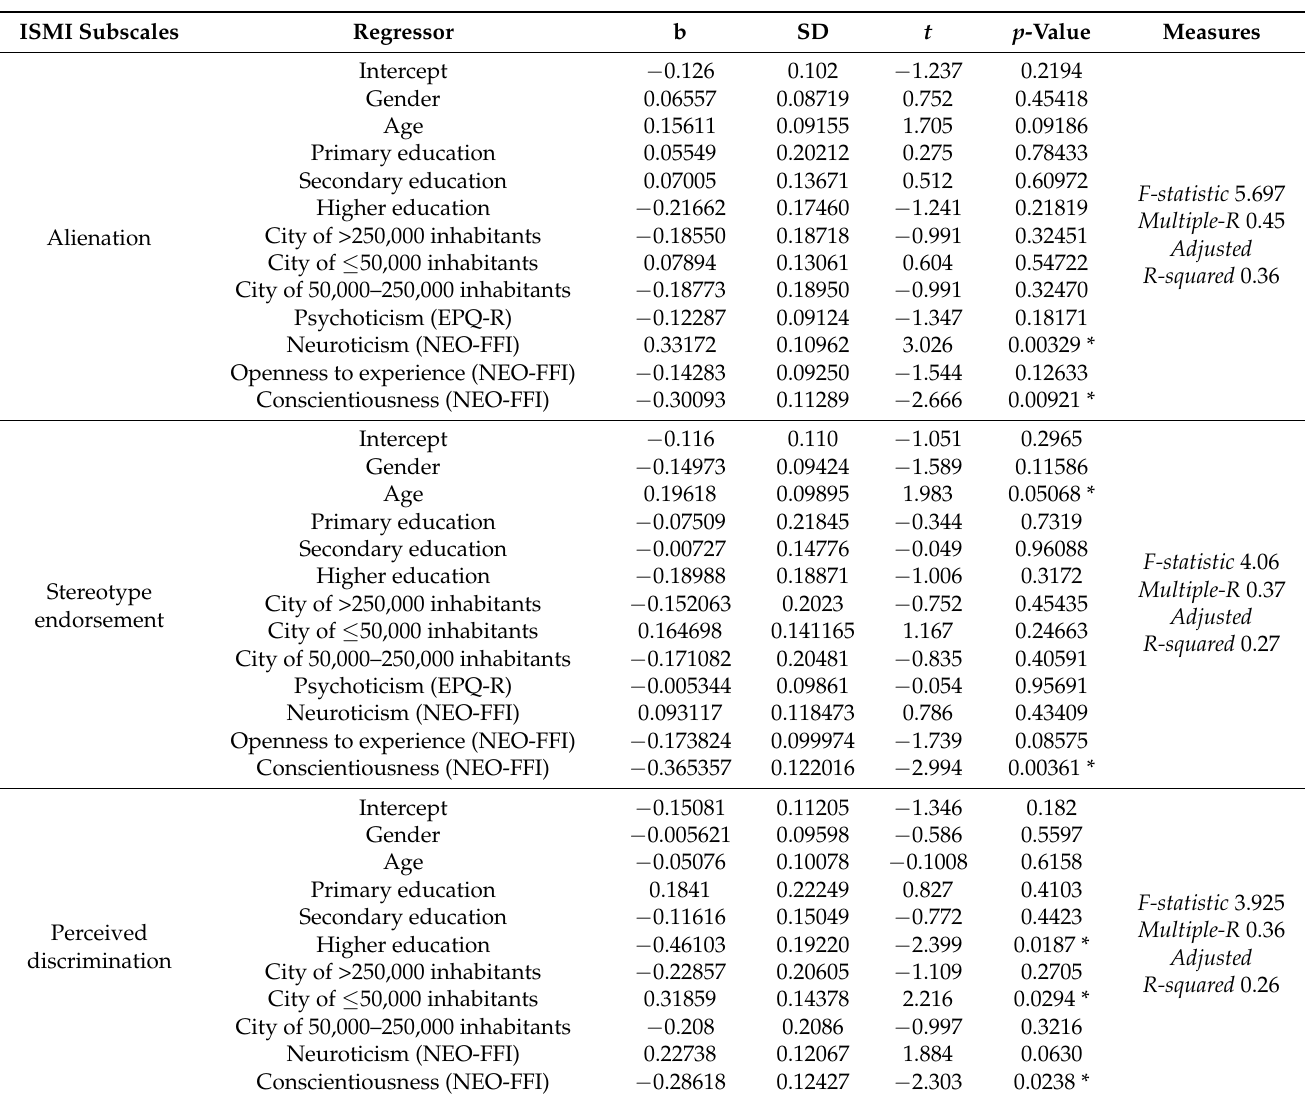
Table 5. Multivariate linear regression analysis with internalized stigma scores on all subscales as independent variables. ISMI